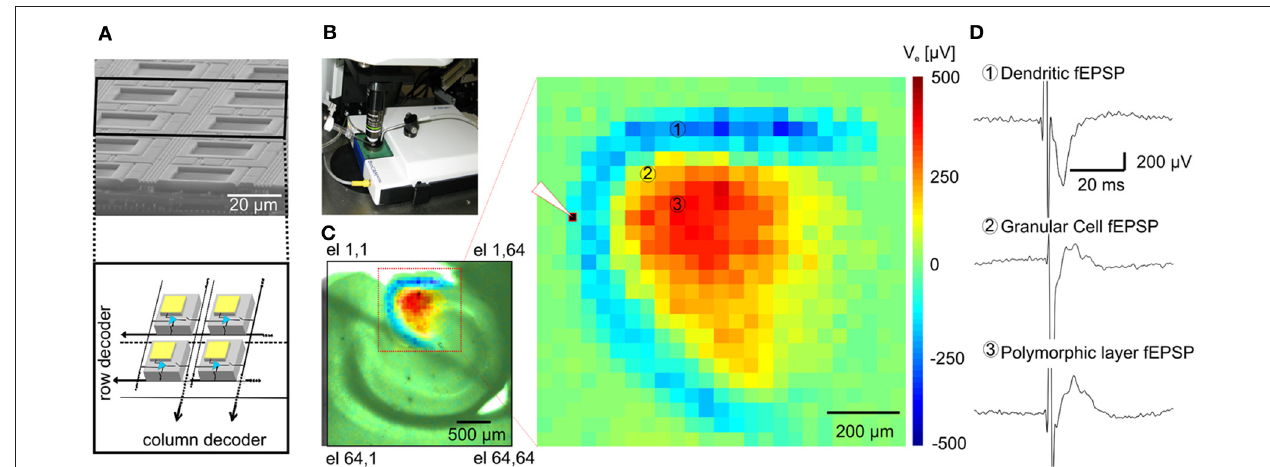
active area of the chip with superimposed color-coded fEPSP activity and close-up on the activated area (the white tip indicates the site of stimulation). (D) Electrophysiological traces of fEPSPs recorded by three APS-MEA electrodes located in the dendritic layer of the dentate gyrus (electrode 1), in the granular cell layer (electrode 2) and in the polymorphic layer (electrode